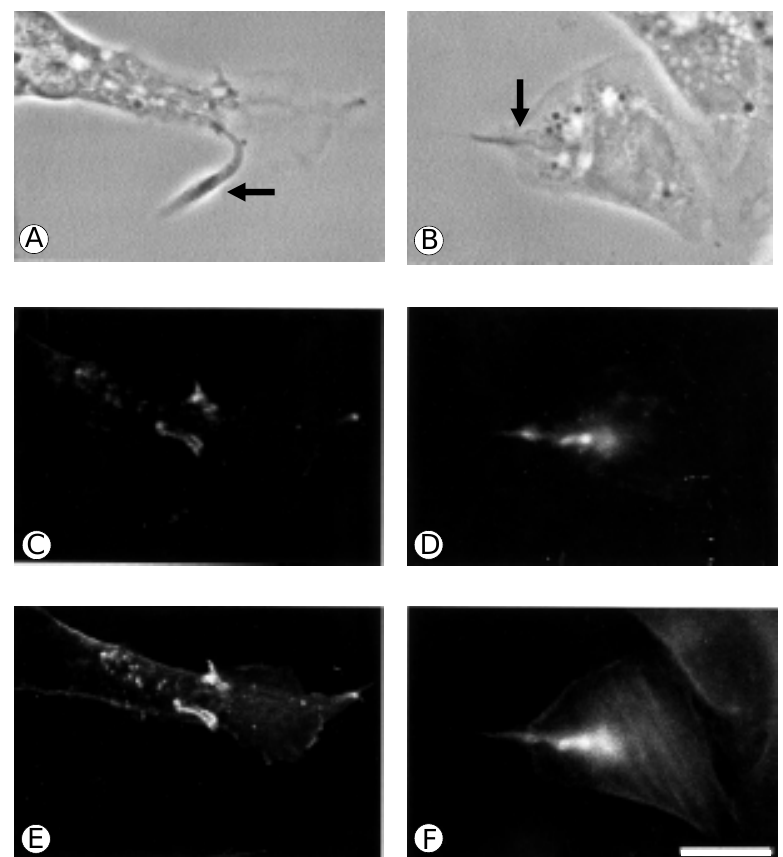
Figure 1 - Parasites allowed to interact with macrophages (arrows). A and B show images by phase contrast microscopy. Visualization of sites of tyrosine phosphorylation (C,D) and actin microfilaments (E,F) in macrophages allowed to interact with trypomastigote forms of Trypanosoma cruzi . Bar = 50